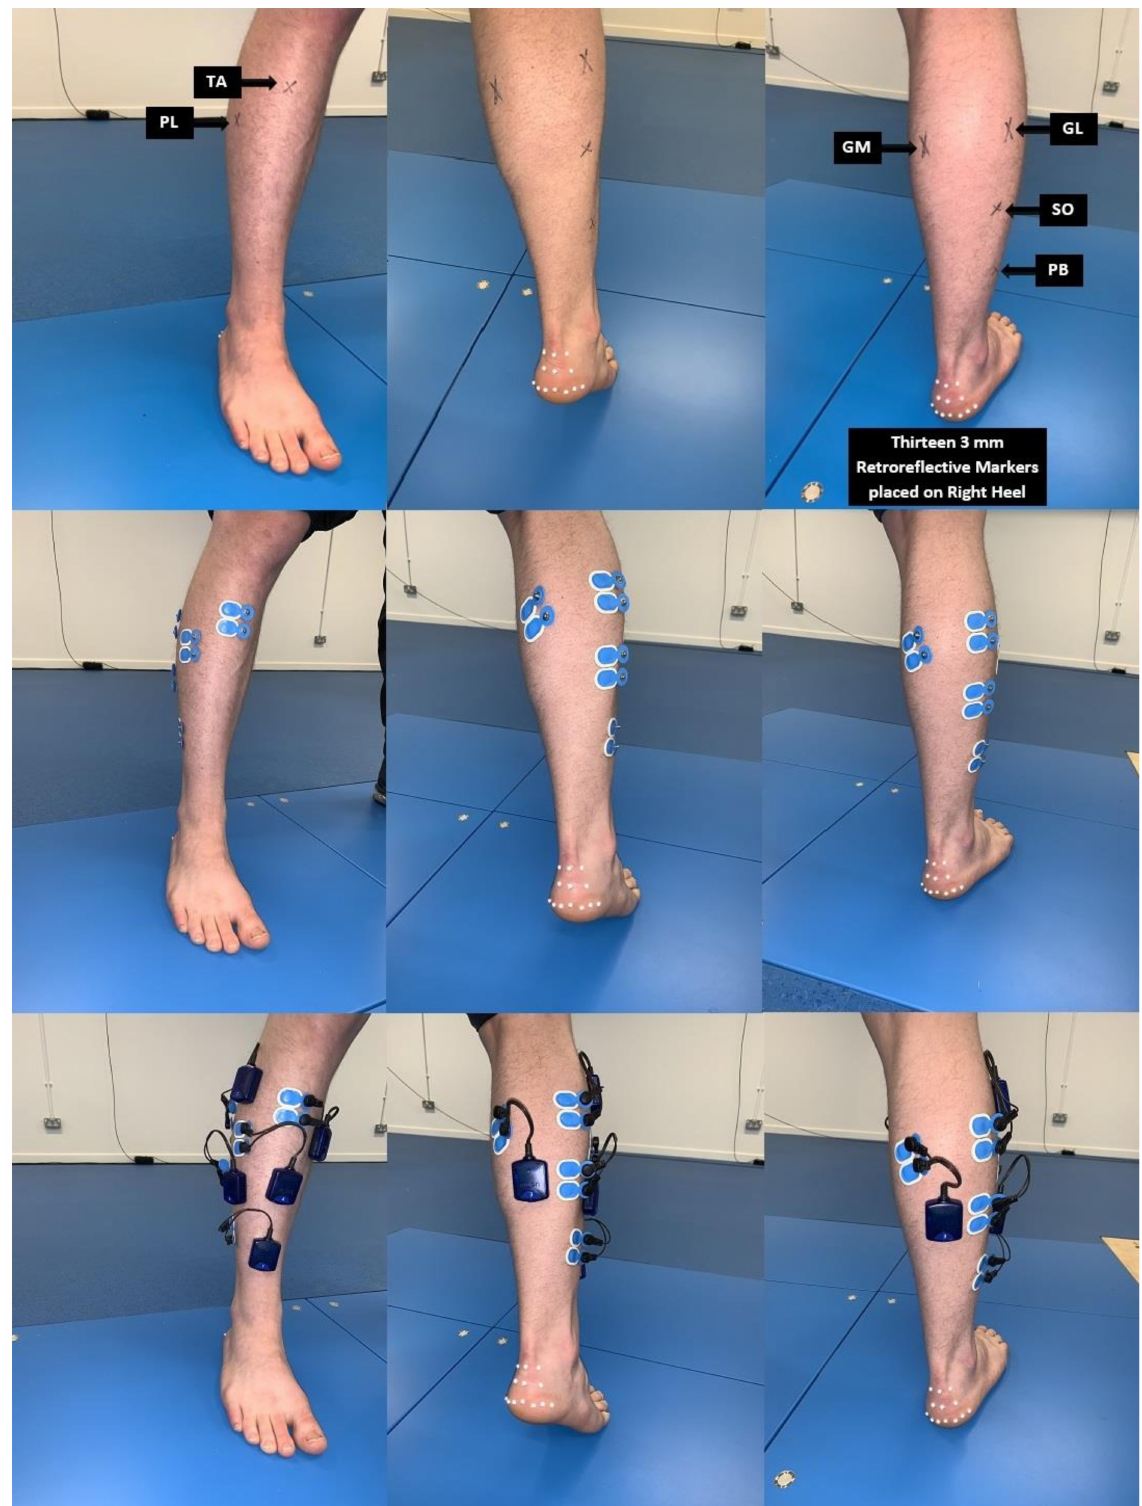
Figure 2. Row 1: Presented on the right leg are marked positions of the lower limb muscles. Row 2: The marked positions are covered with self-adhesive AMBU surface electrodes positioned on the GM, GL, SO, TA, PL and PB. Row 3: The self-adhesive AMBU surface electrodes were connected to the Myon 320 transmitters (transmitters were secured to the calf muscles with double-sided tape). The columns represent the baseline, unloading (concentric) and loading (eccentric) phases of the heel raise task, respectively. Retroreflective markers on the heel were used for tracking the heel phase